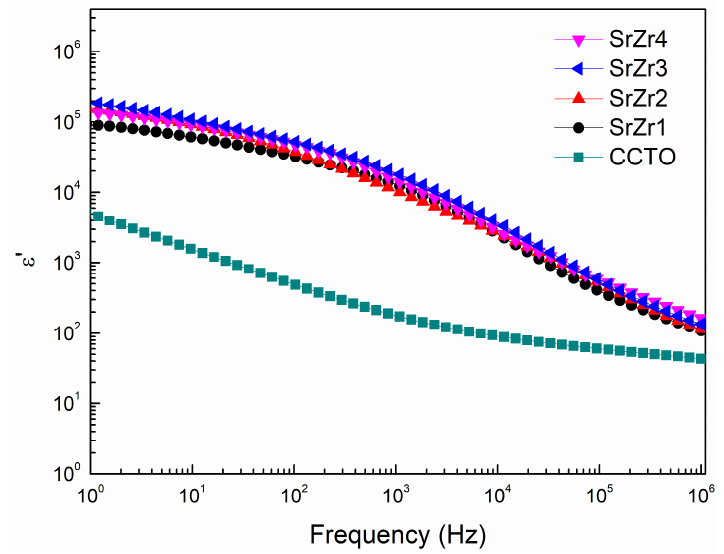
Figure 5. Frequency dependence of the dielectric constant ( ε ') obtained for the CCTO, SrZr1, SrZr2, SrZr3, and SrZr4 ceramics. SrZr3, and SrZr4